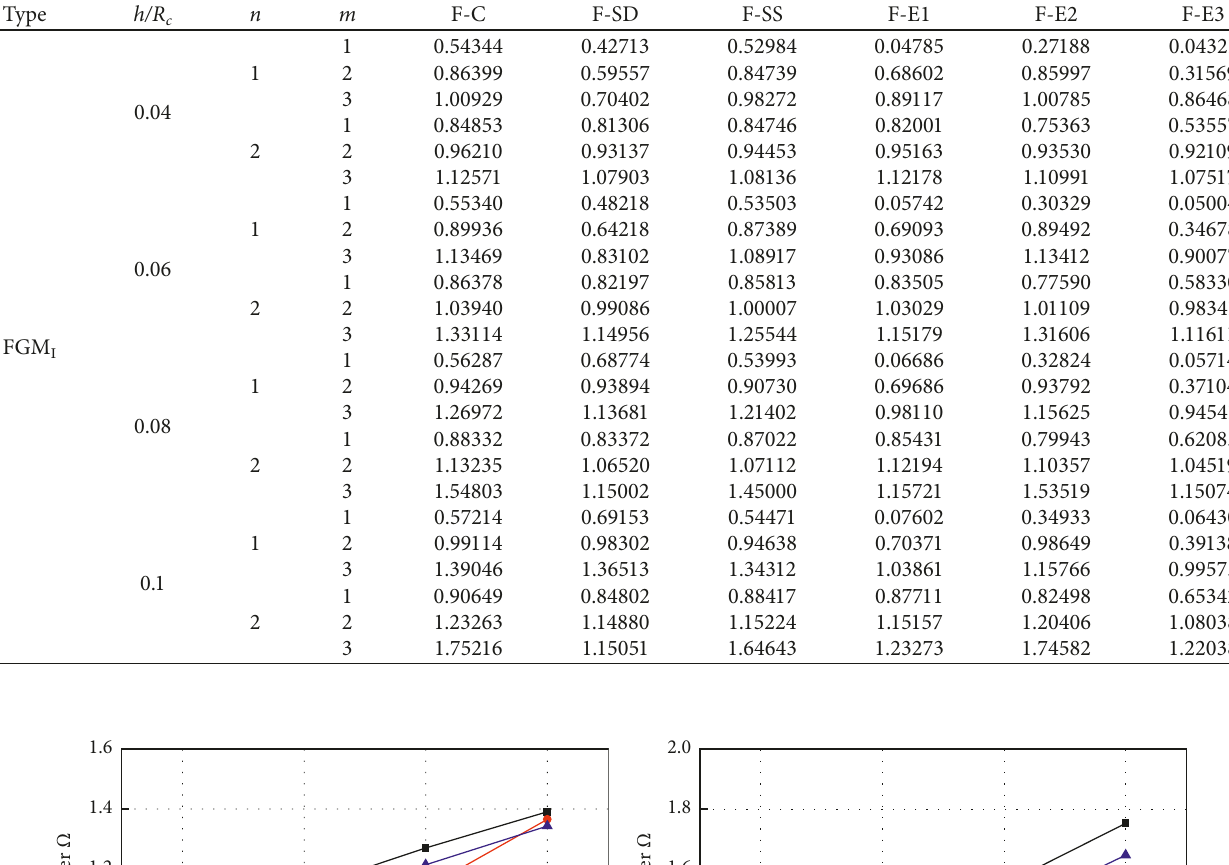
Table 6: Frequency parameters Ω of FG spherical shell with respect to h/R